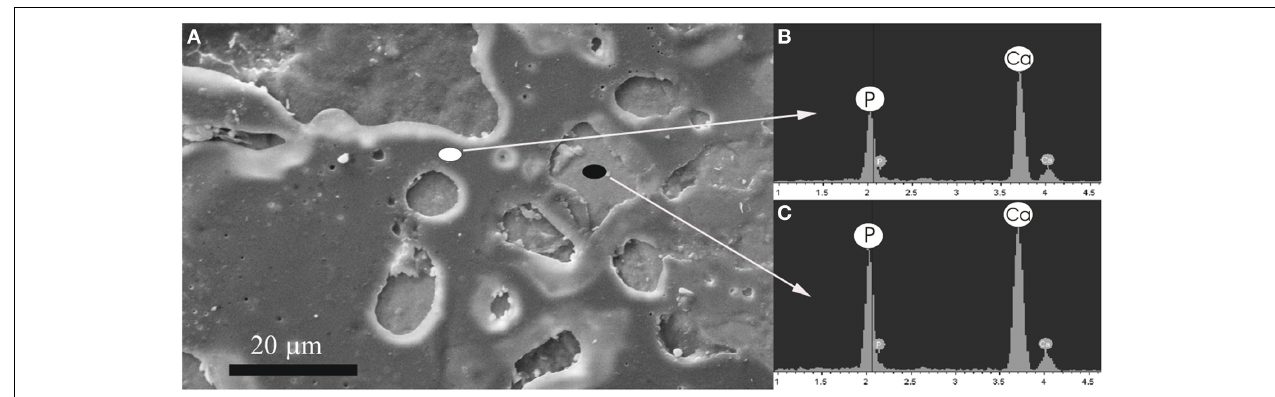
FIGURE 4 | Scanning electron micrograph of the enamel surface of a tooth in vivo treated using the Zn-CHA toothpaste (A), EDAX results using a probe pointed in the area labeled by the white circle (B), EDAX results using a probe pointed in the area labeled by the black circle (C).